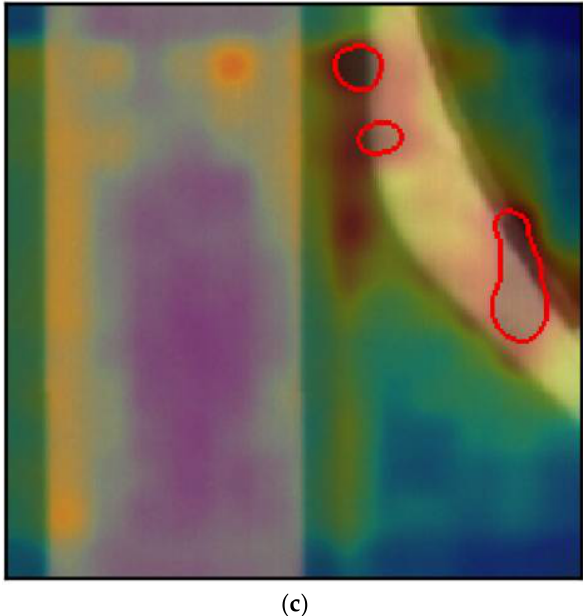
Figure 5. False positive of PCB section. ( a ) False positive example 1; ( b ) False positive example 2; ( c ) False positive example 3.